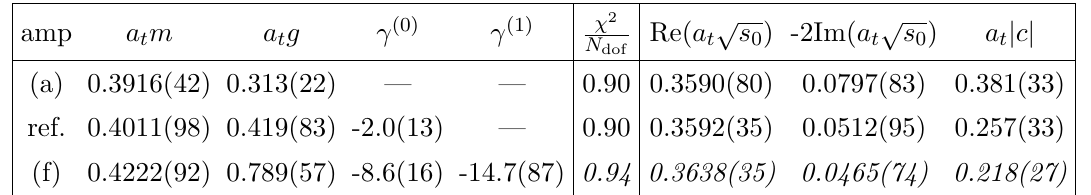
Table 5. The result of varying the number of free parameters in the S -wave amplitude with a two- parameter P -wave as used in eq. (4.9). “ref.” indicates the reference amplitude, eq. (4.9). The final amplitude (f) results in a parameterisation that produces two poles, one of them around a t m ≈ 0 . 29 , far below threshold. The italics highlight that this amplitude contains this lower resonance